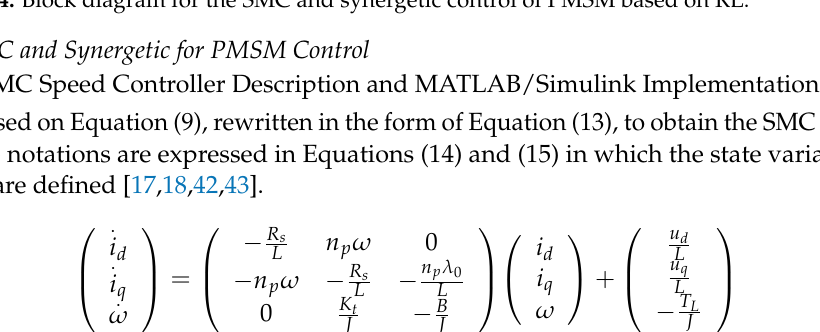
Figure 14. Block diagram for the SMC and synergetic control of PMSM based on